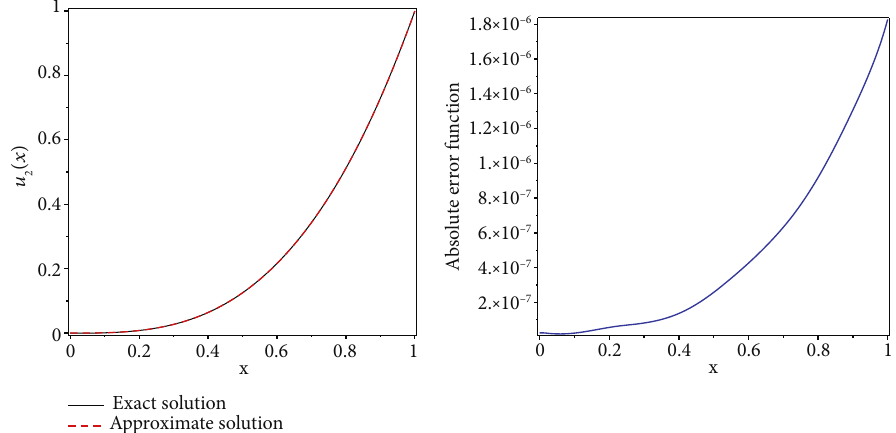
ð x Þ for N = 9 and ν 2